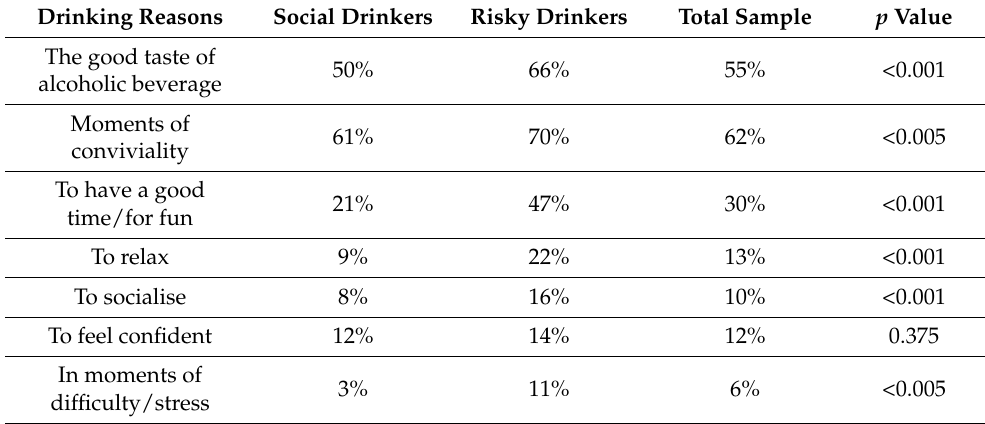
Table 2. Frequencies of reported drinking reasons in social and risk drinkers.